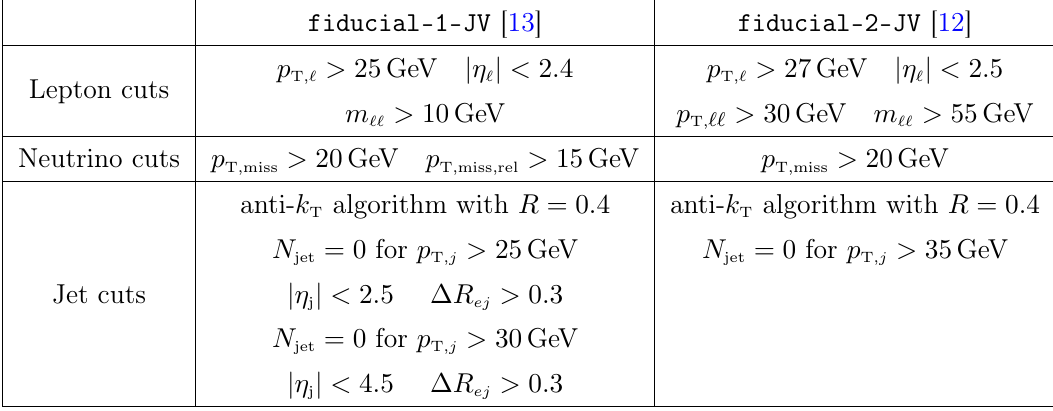
Table 1. Fiducial cuts used in two different setups, see text for